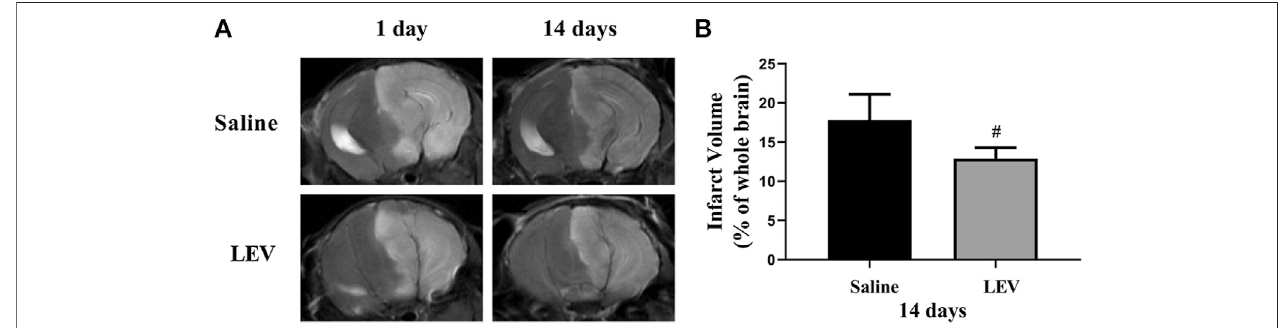
FIGURE 2 | Cerebral infarction with levetiracetam (LEV) treatment reduced cerebral infarct volume in middle cerebral artery occlusion (MCAO) rats. (A , B) . Brain infarct volume was detected by T2-weighted magnetic resonance imaging (MRI). LEV treatment signi fi cantly reduced the cerebral infarct volume of MCAO rats on the 14th day. N (cid:1) 12 per group. # p < 0.01 compared to the saline group.